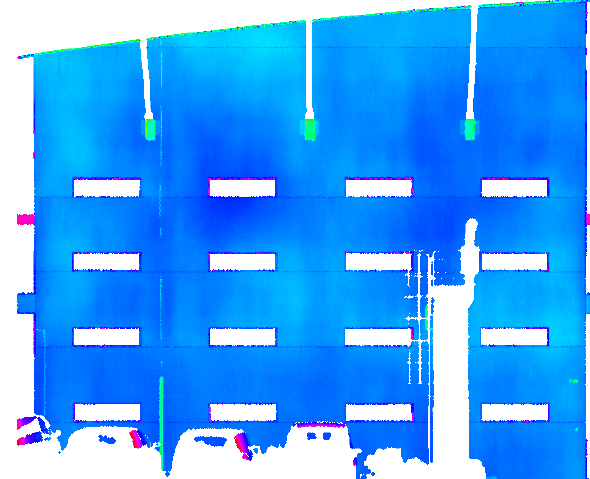
Figure 4: Geometry model of the facade of an industrial building